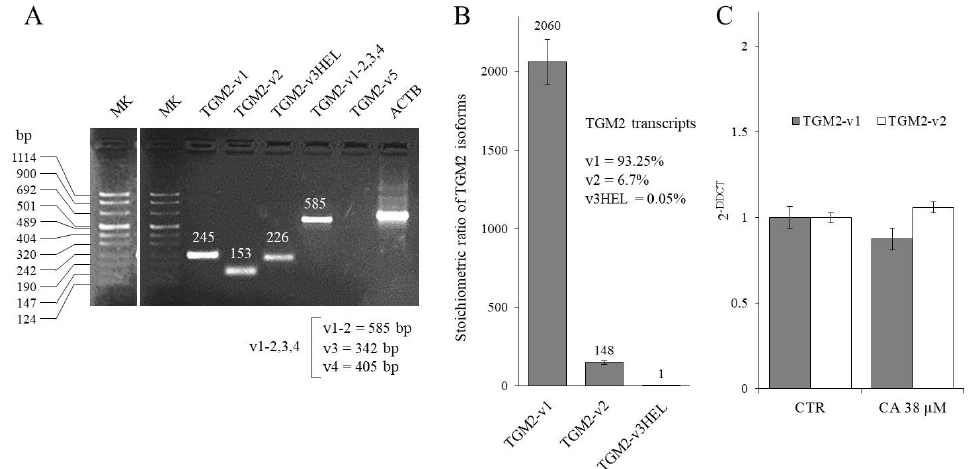
Figure 3. Characterization of TGM2 variants in K562 cells, before and after the CA-treatment. ( A ) Semi-quantitative RT-PCR analysis of TGM2 variants. The molecular weights expected from the amplification of the different TG2M variants with the primers couple TGM2 v1-2,3,4 are indicated in the lower part of the panel. ( B ) RT-qPCR of the TGM2 transcript variants expressed in K562 cells. Data are expressed as arithmetic mean ± SD. ( C ) RT-qPCR analysis of predominant TGM2 transcript variants after the treatment with CA. Data are expressed as arithmetic mean ±